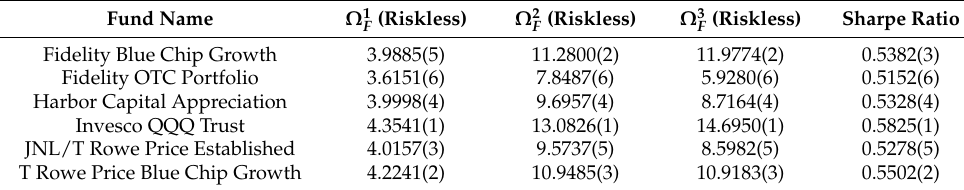
Table 2. The 1st-, 2nd-,3rd-order Omega and Sharpe Ratio.